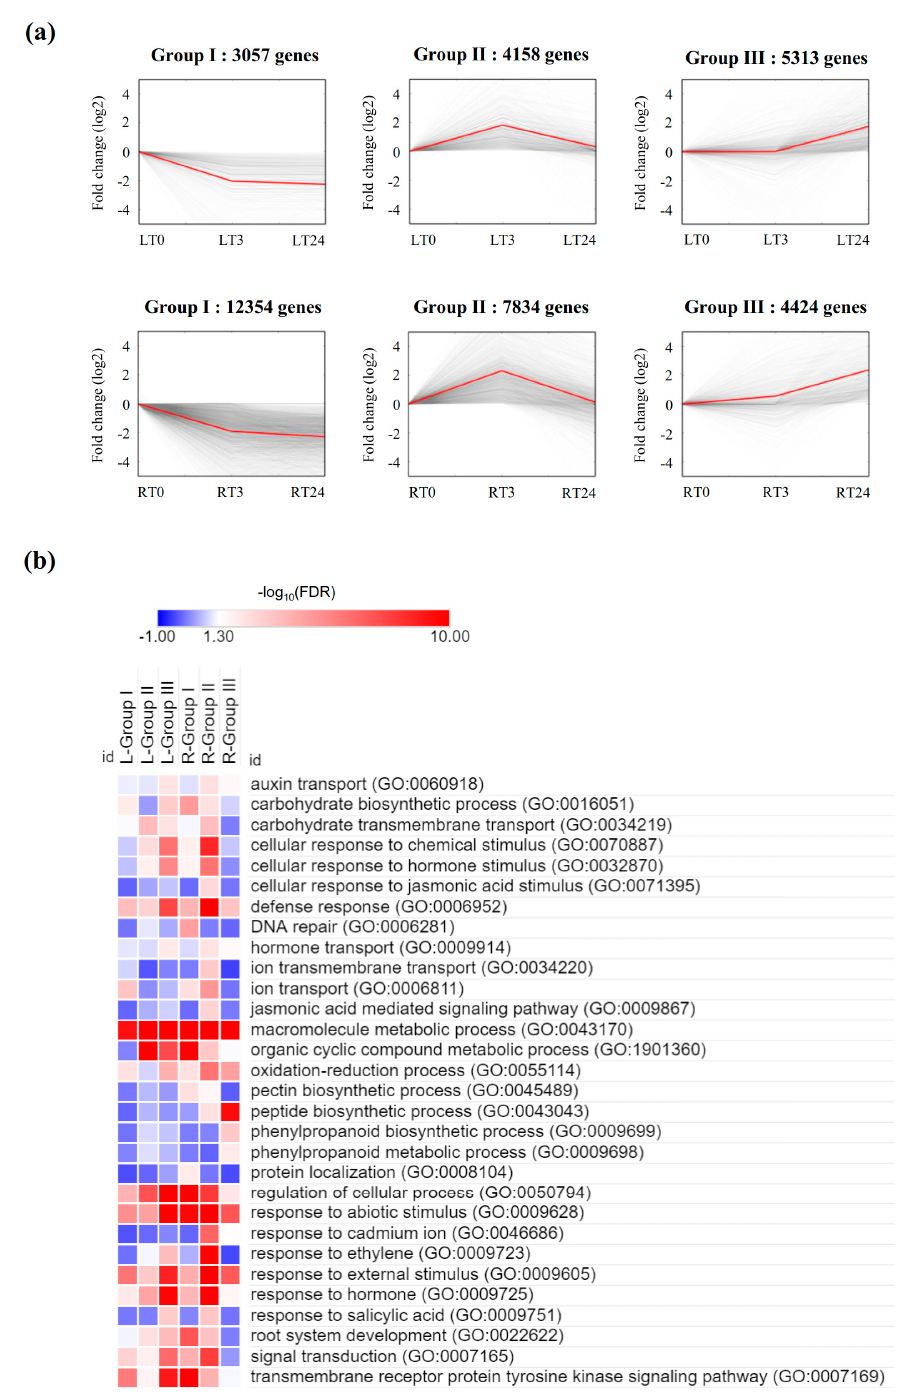
Figure 4. Patterns of gene expressions and Gene ontology (GO) enrichment across three time points in leaves and roots. ( a ) Patterns of gene expressions across three time points in leaves and roots inferred by K-means clustering analysis. In each frame, the light gray lines represented the expression pattern of each gene while the red line represented the expression tendency of all the genes. ( b ) GO enrichment analysis of three significant clusters in leaves and roots. The significance of the most represented GO-slims in each main cluster is indicated by false discovery rate (FDR) value. The red areas represented the significant FDR values, whereas the white and blue represented the nonsignificant values.